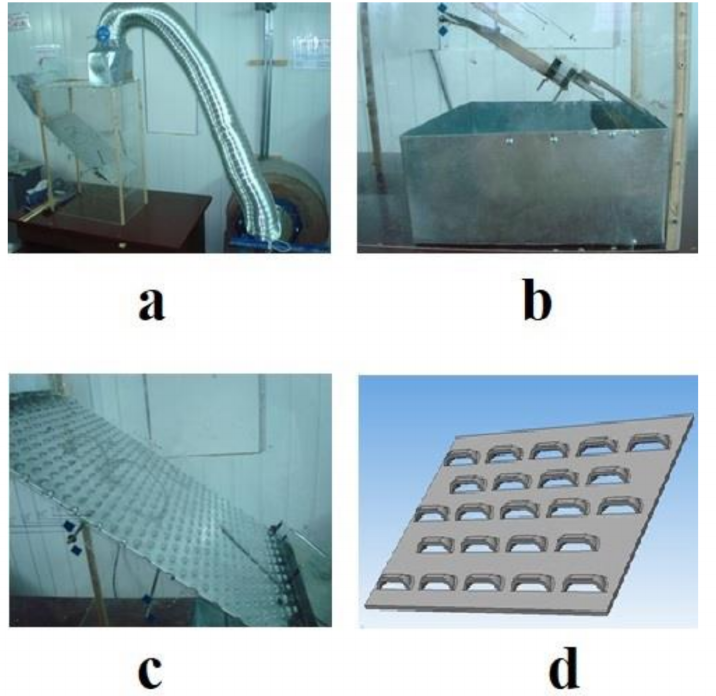
Figure 3. Laboratory unit for research of purification process of preliminarily stratified grain mixture: ( a ) general appearance; ( b ) grain receiver; ( c , d ) breathable scaly